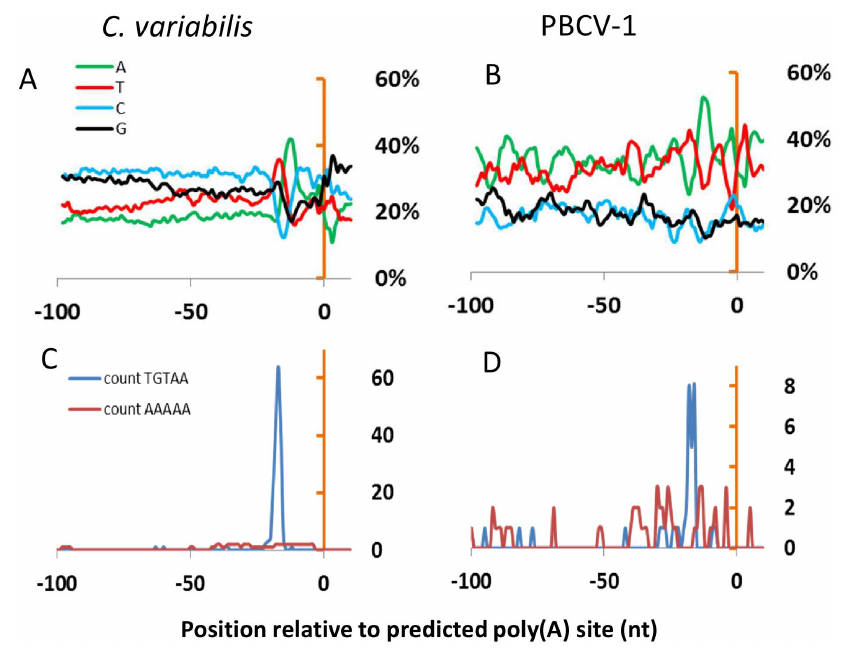
Figure 4. Putative polyadenylation signals in C.variabilis and PBCV-1. (A), (B) Nucleotide frequencies within 100 nucleotides upstream from the predicted poly(A + ) site in C. variabilis and PBCV-1 genes, respectively. Curve profiles were smoothed using the average of 5 neighboring positions. (C), (D) Distribution of putative poly(A + ) signals within 100 nucleotides upstream of the predicted poly(A + ) site in C. variabilis and PBCV-1 genes respectively.